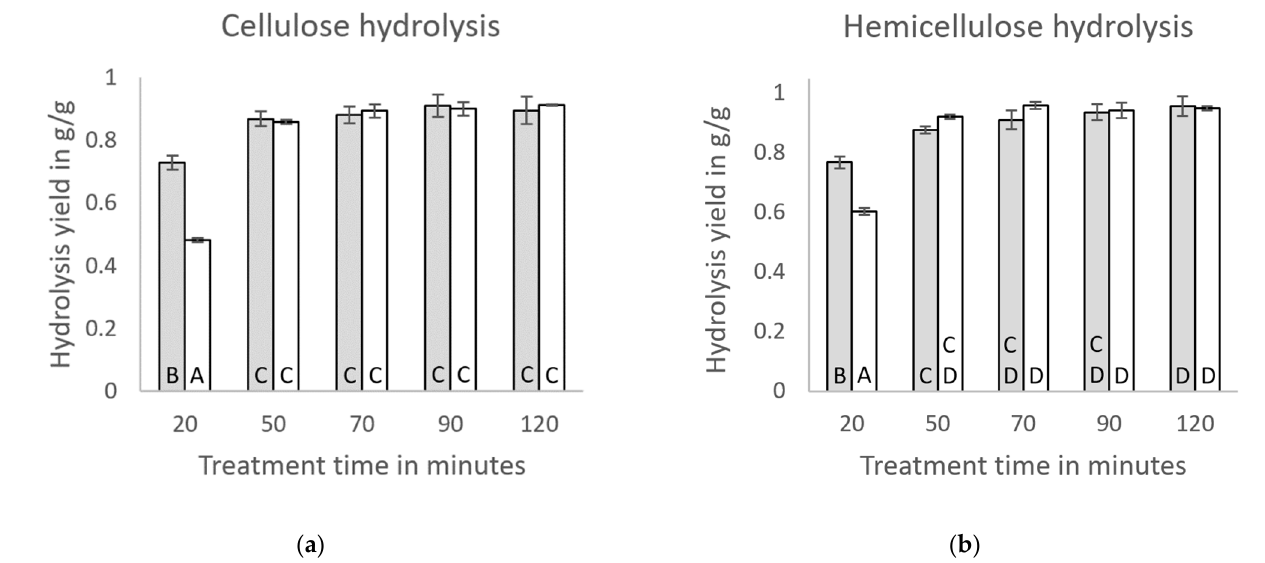
Figure 5. Enzymatic hydrolysis of hydrothermally pretreated raw digestate (filled in gray) and washed digestate (no filling). ( a ) Hydrolysis yield of cellulose-related glucose as a function of hydrothermal pretreatment time; ( b ) hydrolysis yield of the hemicellulose-related sugars xylose and arabinose as a function of hydrothermal pretreatment time. Hydrothermal treatments were performed in duplicates and for each treated sample, enzymatic treatment was performed in duplicates again (the error bars reflect the standard deviation observed among all these samples). Within one figure, the letters A to D indicate whether the differences between the mean values are significant according to the Tukey–Kramer test at a significance level of α = 0.05. Results that share a letter are not significantly different from each other.